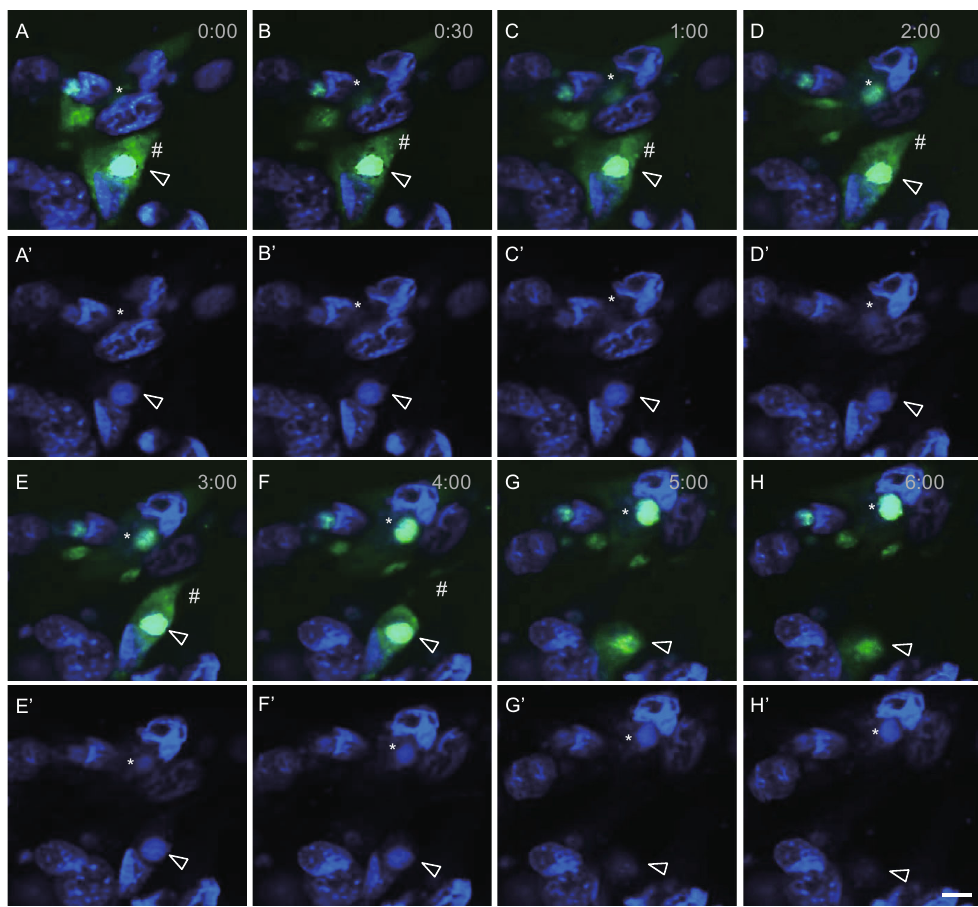
Figure 5. Visualization of viral assembly site formation and disassembly. 88GFP-HX1 cells were infected with SGIV, stained for nuclei and VAS with Hoechst 33342 (blue). Time-lapse images represented stages of VP88GFP redistribution at intervals from 48 hpi onwards (For more details, see Movie S1 in the supplemental material). Upper panel, merged signals of VP88GFP and Hoechst 33342, showing colocalization of VP88GFP and VAS. Lower panel, signal of Hoechst 33342 showing the nuclei and VAS. Asterisk, the ongoing formation of VAS; triangle, earlier formed VAS containing VP88GFP; hash, release of cellular components containing VP88GFP. Scale bar,